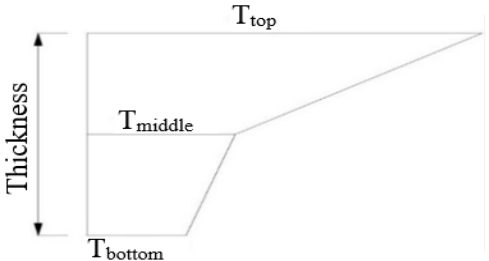
Figure 11. Bilinear temperature change in concrete slab.